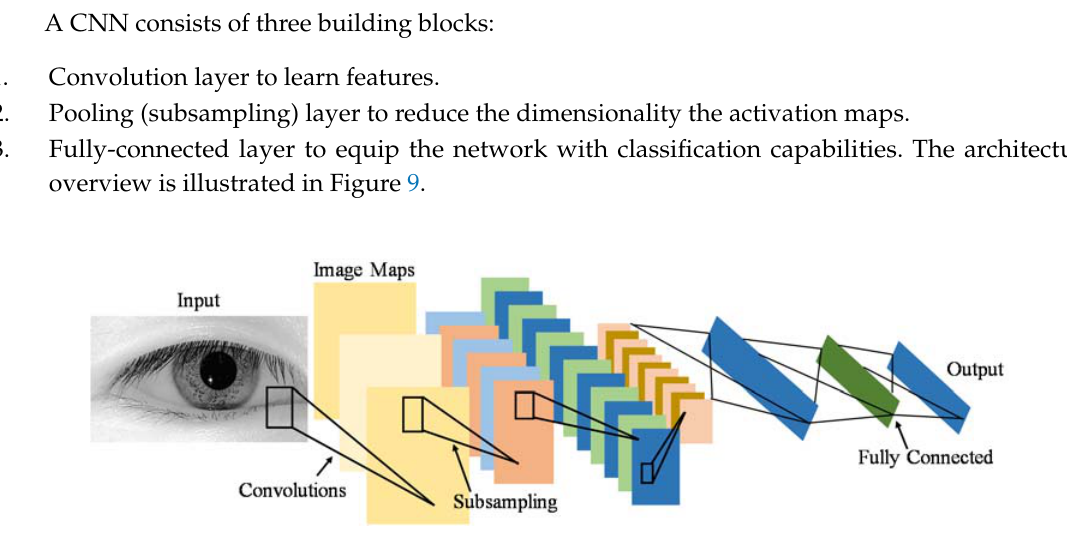
Figure 9. Convolutional Neural Network (CNN) architecture.